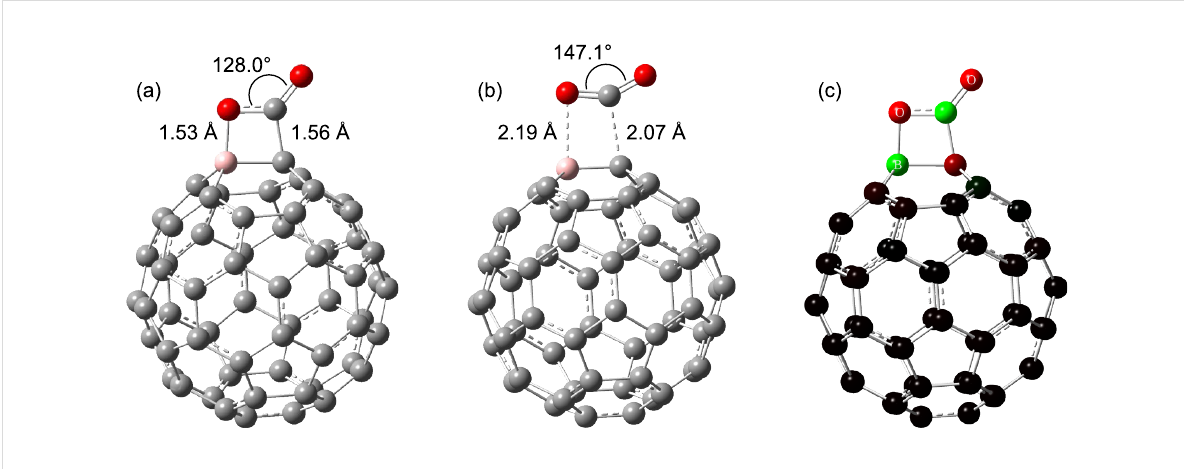
Figure 5: (a) CO 2 chemisorption and (b) transition structure for CO 2 chemisorption on 1 e − -charged BC 59 . Atom colour code: grey, carbon; pink, boron; red, oxygen. (c) Charge distribution after CO 2